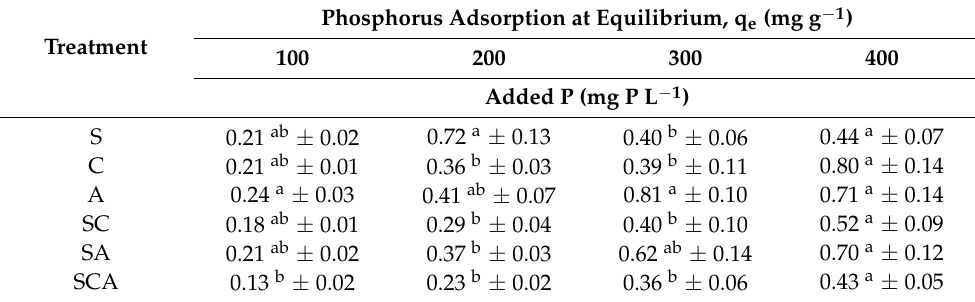
Table 3. Effects of treatments on the amounts of phosphorus adsorbed at equilibrium at different concentrations of added phosphorus.